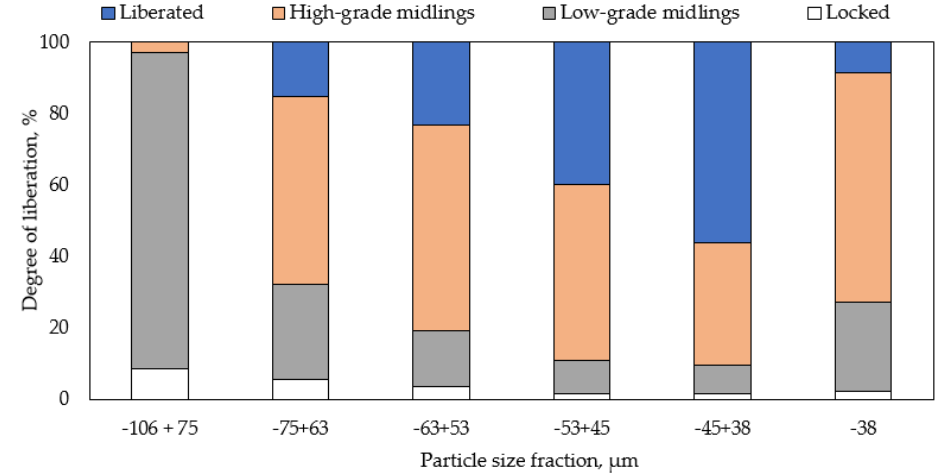
Figure 6. Magnetite liberation in various size fractions of the ore.